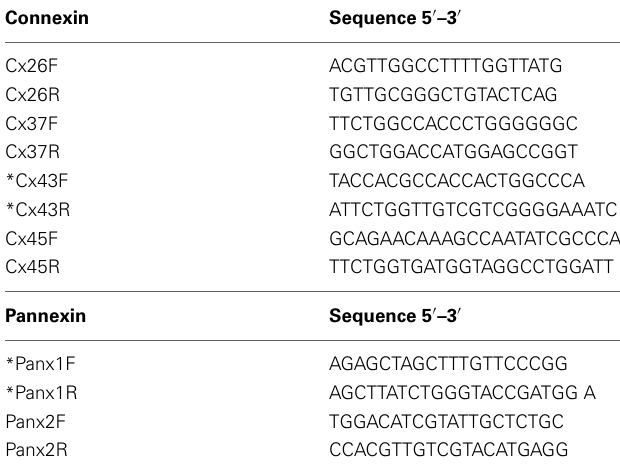
Table 1 | Sequences of RT-PCR primers used to detect Cxs and Panxs mRNAs in rat’s